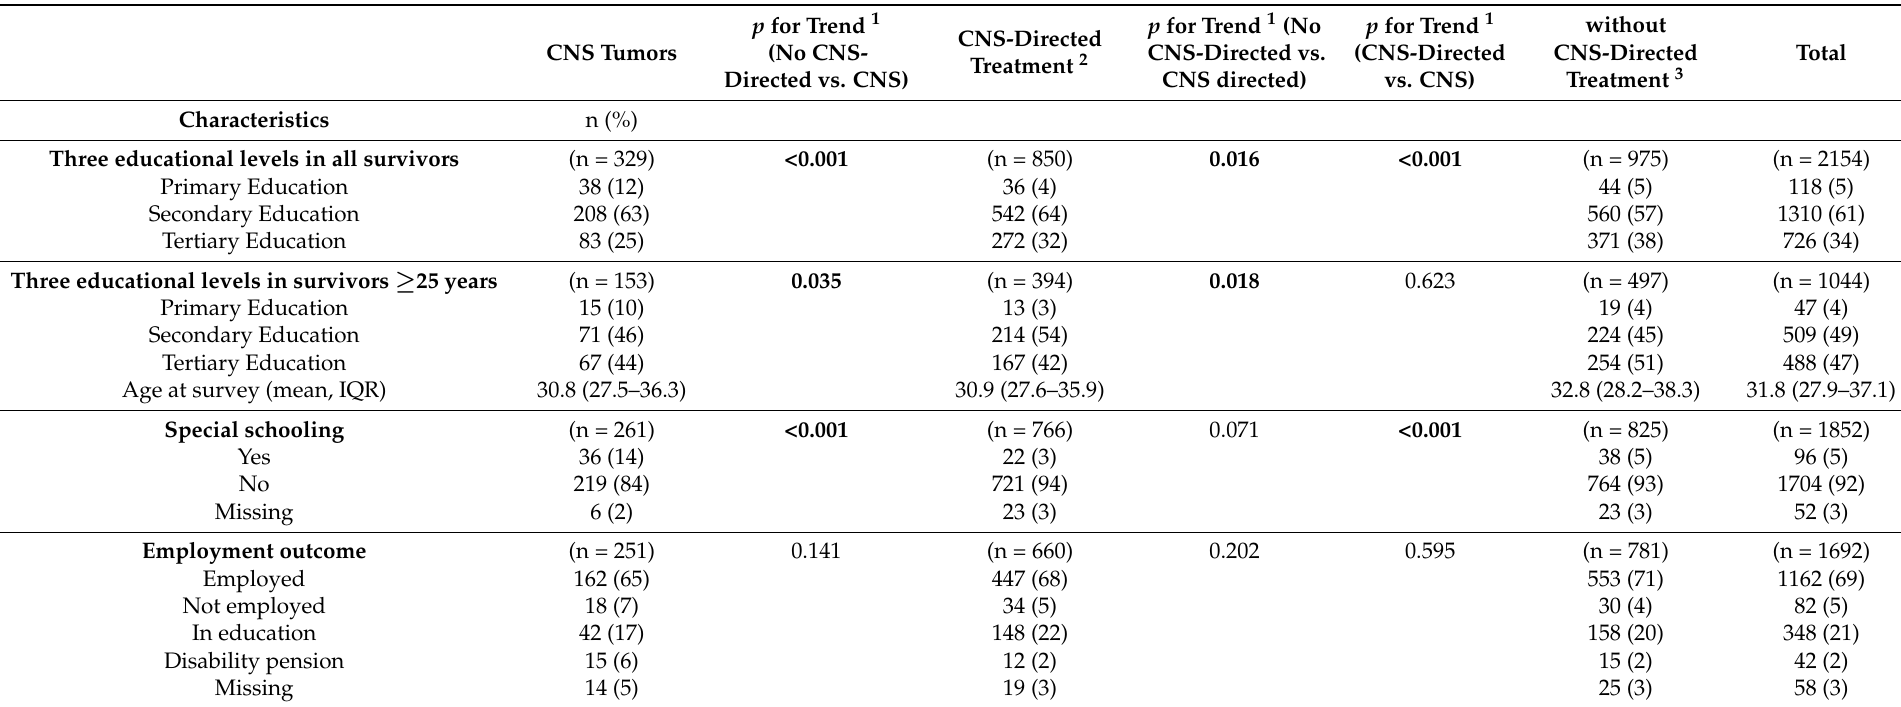
Table 2. Educational attainment, special schooling, and current employment status in adult and adolescent childhood cancer survivors; N =